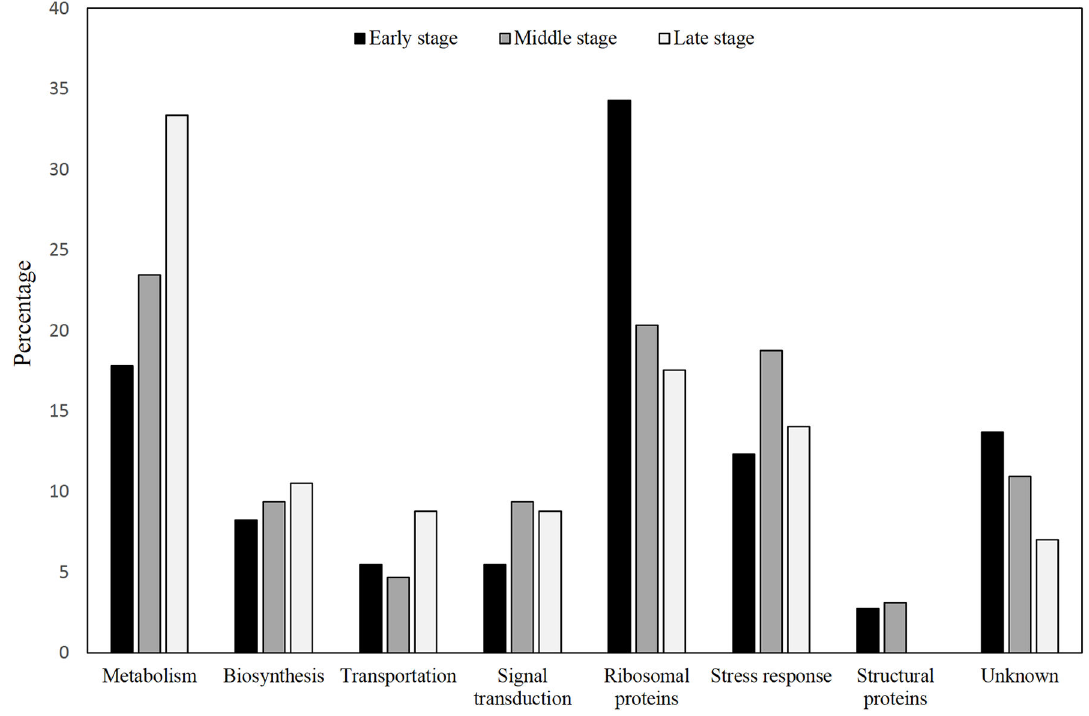
Figure 5. Functional distribution of proteins identified during each lipid accumulation stage. Proteins were classified into eight groups according to their different functions. The percentage of proteins of each function out of the whole proteins identified at each stage were exhibited.